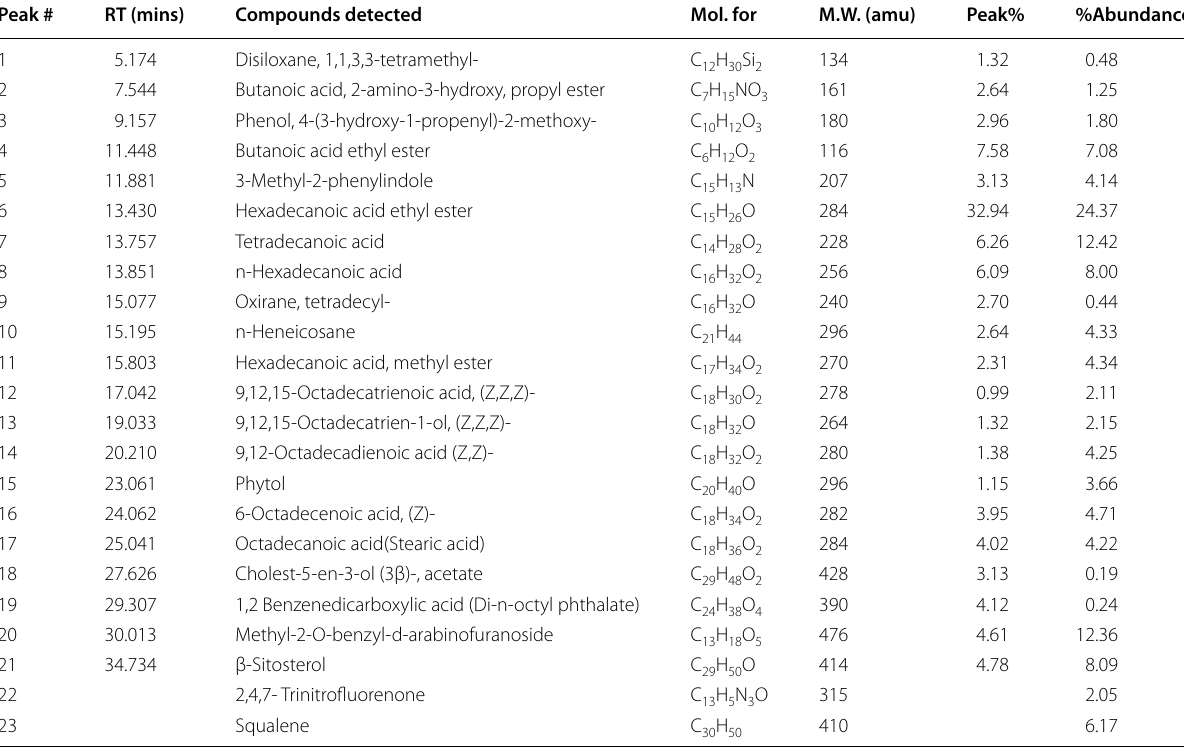
Table 4 Bioactive compounds of aqueous extracts of Vernonia amygdalina leaf